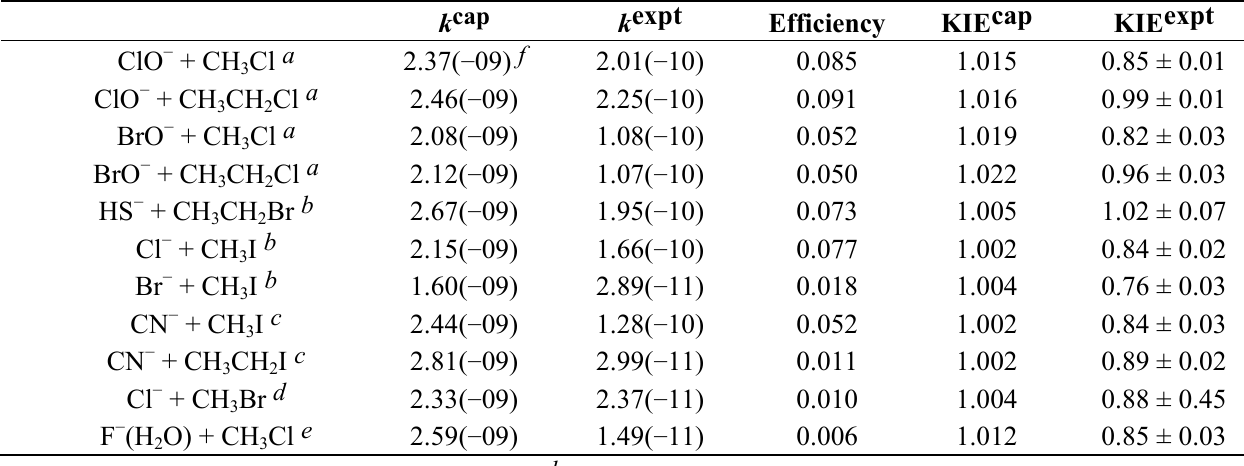
Table 3. Experimental and calculated capture rate constants (in cm 3 molecule − 1 s − 1 ) and deuterium KIEs of eleven gas-phase S room